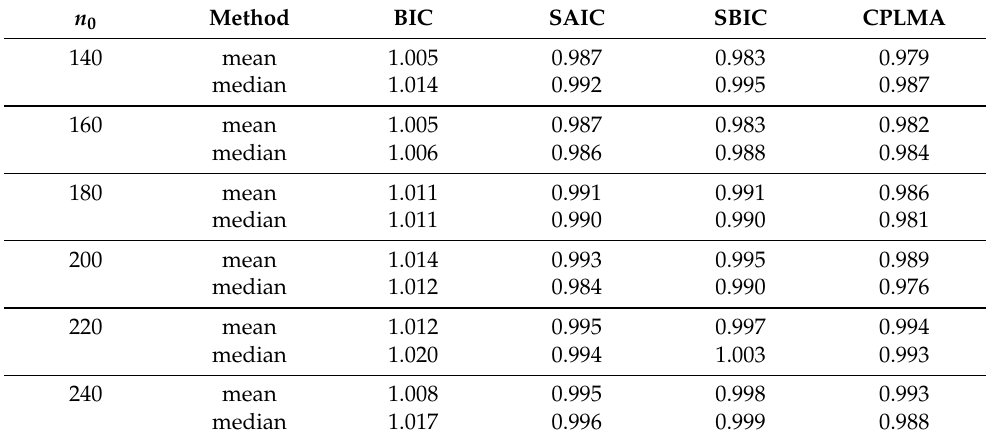
Table 2. The mean and median of RMSPE across 1000